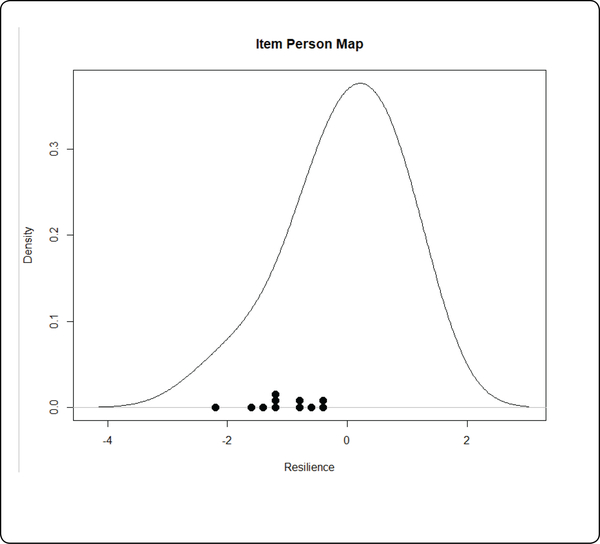
Person-item Map.